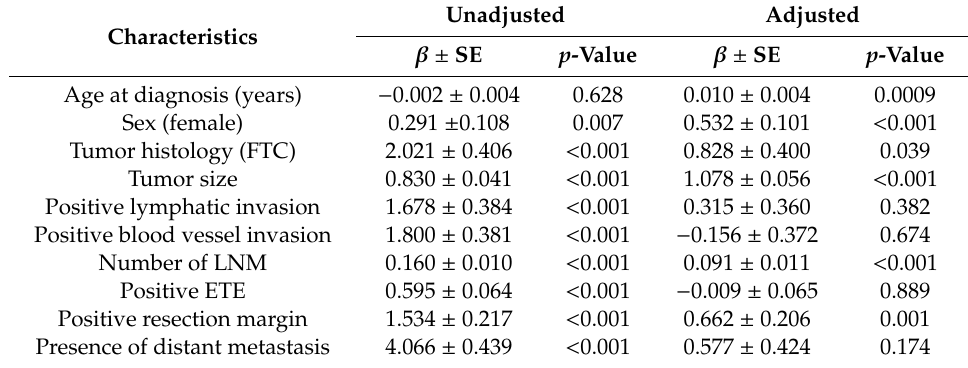
Table 2. Multivariate linear regression analysis results showing factors associated with preoperative serum thyroglobulin deciles.